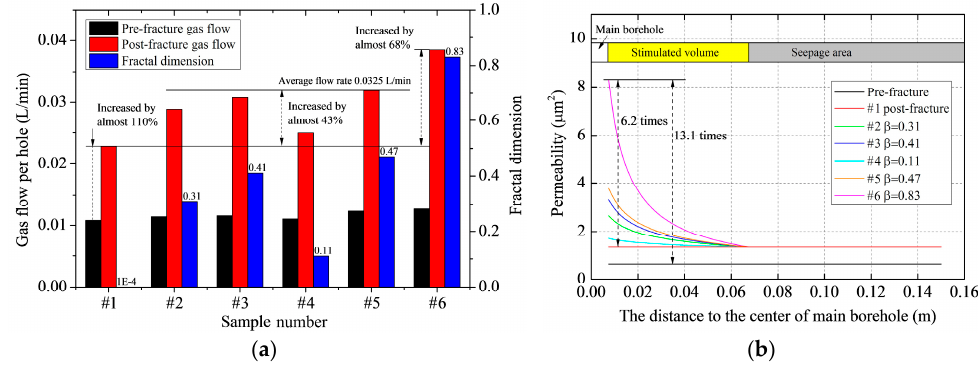
Figure 5. Gas seepage experimental results after tree-type fracturing. ( a ) Gas flow rates and fractal dimension; ( b )